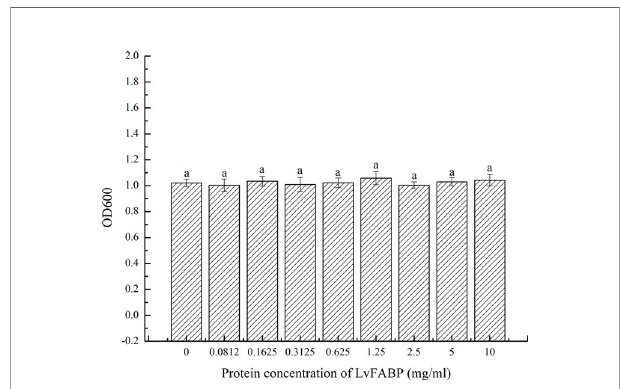
FIGURE 8 | Antibacterial effect of LvFABP protein on VP-E1. VP-E1 suspension (200 m l) prepared was added to the 96-well plate, then LvFABP protein (100 m l) with different concentrations (10 mg/mL, 5 mg/mL, 2.5 mg/ mL, 1.25 mg/mL, 0.625 mg/mL, 0.3125 mg/mL, 0.1625 mg/mL, 0.0812 mg/ mL) were added, and 100 m l PBS was added to the control group, and three experiments were repeated in each group. After incubation at 30°C for 24 h, the turbidity was recorded by a microplate reader. Each bar represents the mean ± standard deviation (SD) of triplicate